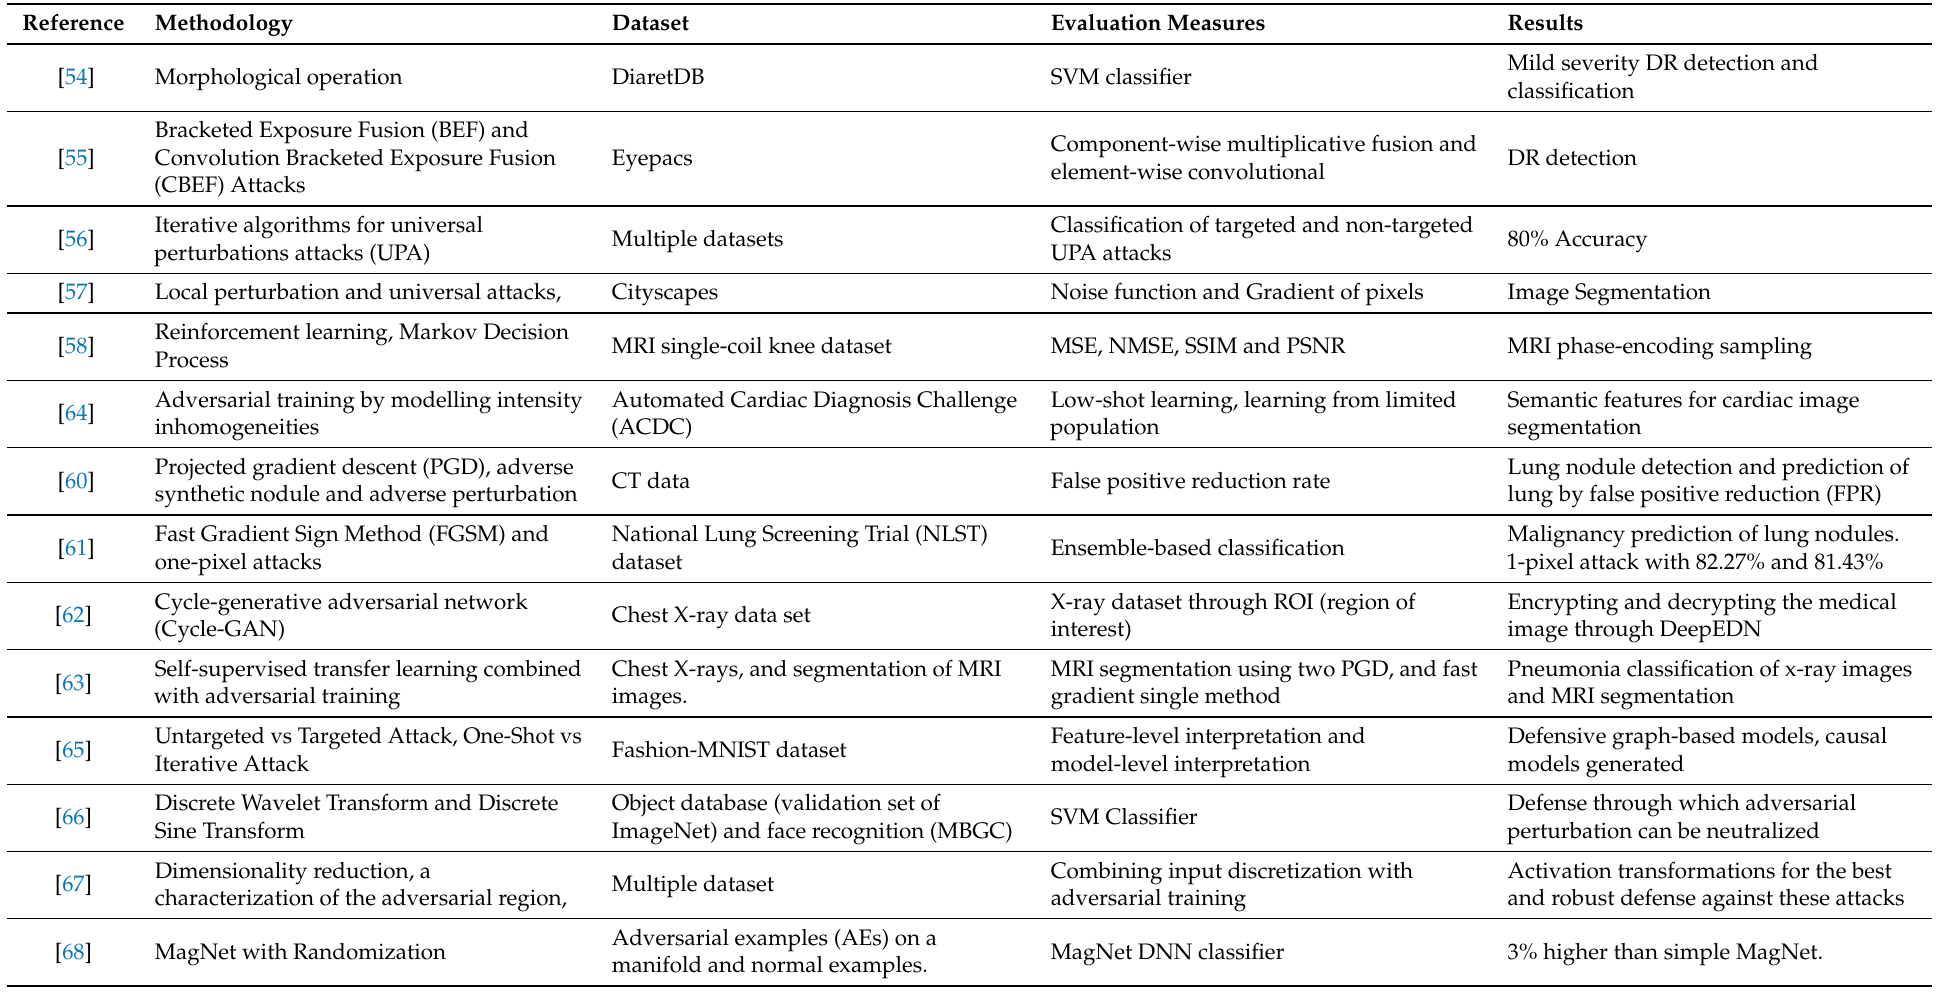
Table 1. Comparison of recent related works with their